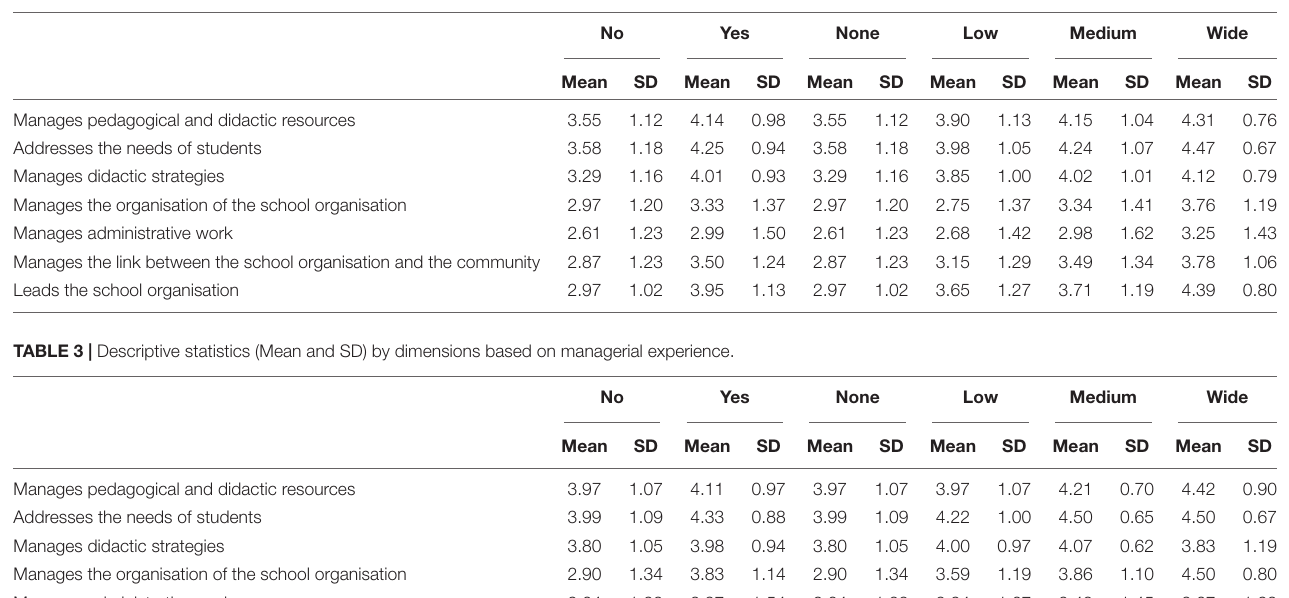
TABLE 2 | Descriptive statistics (Mean and SD) by dimensions based on teaching experience.